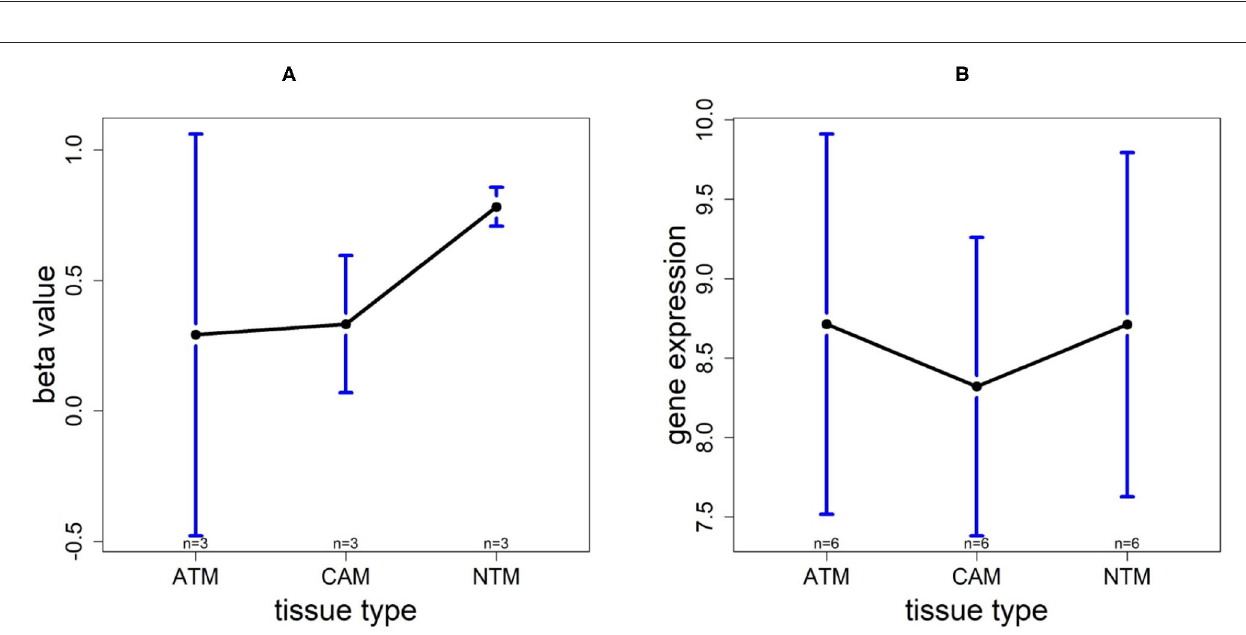
FIGURE 10 | The overall methylation and gene expression levels of the CLDN11 promoter region. (A) Averaged methylation level over the three samples of gene CLDN11 among tissue types from GSE97686 dataset. (B) Averaged gene expression level over the three samples of gene CLDN11 among tissue types from GSE107161 dataset. The blue bars represent 95% confidence intervals. Some error bars are large as the sample size is only 3 in each tissue type.